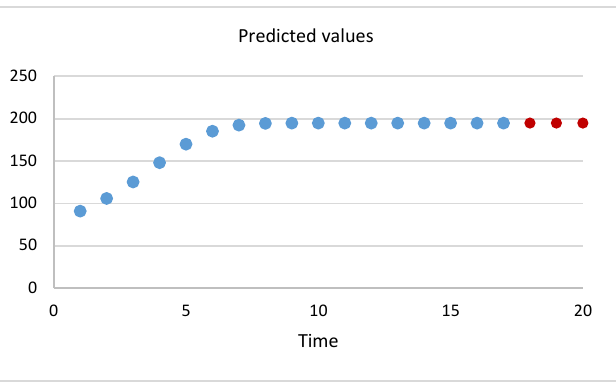
Figure 5. Predicted values by proposed model for dataset 1.